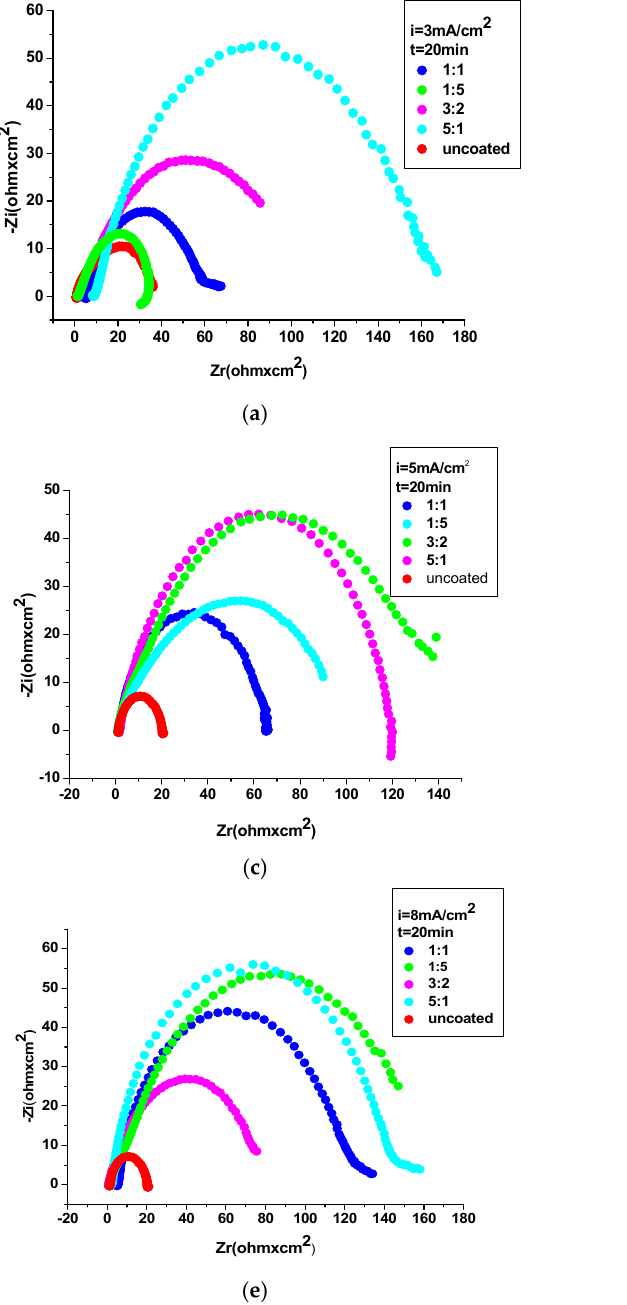
Figure 9. Nyquist plots for uncoated and PNMPY-TRX100/PNNDEA-coated OL 37 electrode by galvanostatic method at 3mA/cm 2 for 20min ( a ) and 30min ( b ), at 5mA/cm 2 for 20min ( c ) and 30min ( d ), at 8mA/cm 2 for 20min ( e ) and 30min ( f ) at varied molar ratios for PNMPY-TRX100 and PNNDEA.